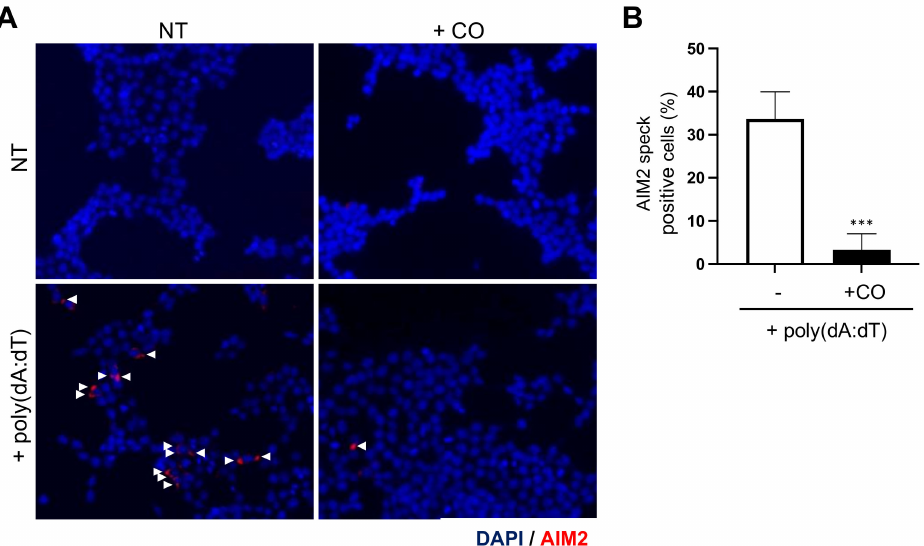
Figure 5. CO inhibits AIM2 speck formation resulting from poly(dA:dT) stimulation. ( A , B ) HEK293T cells were transfected with a FLAG-tagged AIM2 expression vector 24 h prior to the experiment. Cells were pre-treated with CO (10 µ g/mL) for 30 min, then stimulated with poly(dA:dT) (1 µ g/mL) for 4 h. ( A ) AIM2 speck images at 400 × magnification upon stimulation with poly(dA:dT) in cells expressing FLAG-tagged AIM2. AIM2 and nuclei are depicted in red and blue (DAPI), respectively. White arrowheads point to AIM2 speck. ( B ) Statistical analysis of the AIM2 specks showing the percentage of positive cells. At least three fields and more than 100 cells were counted for each condition. Data represent the means ± SDs of three independent experiments; *** p <